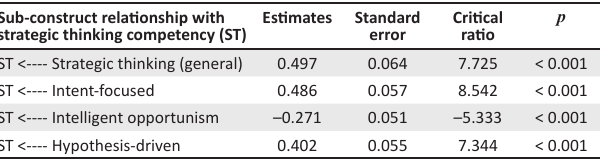
TABLE 8: Structural model parameter estimates and p -values for strategic